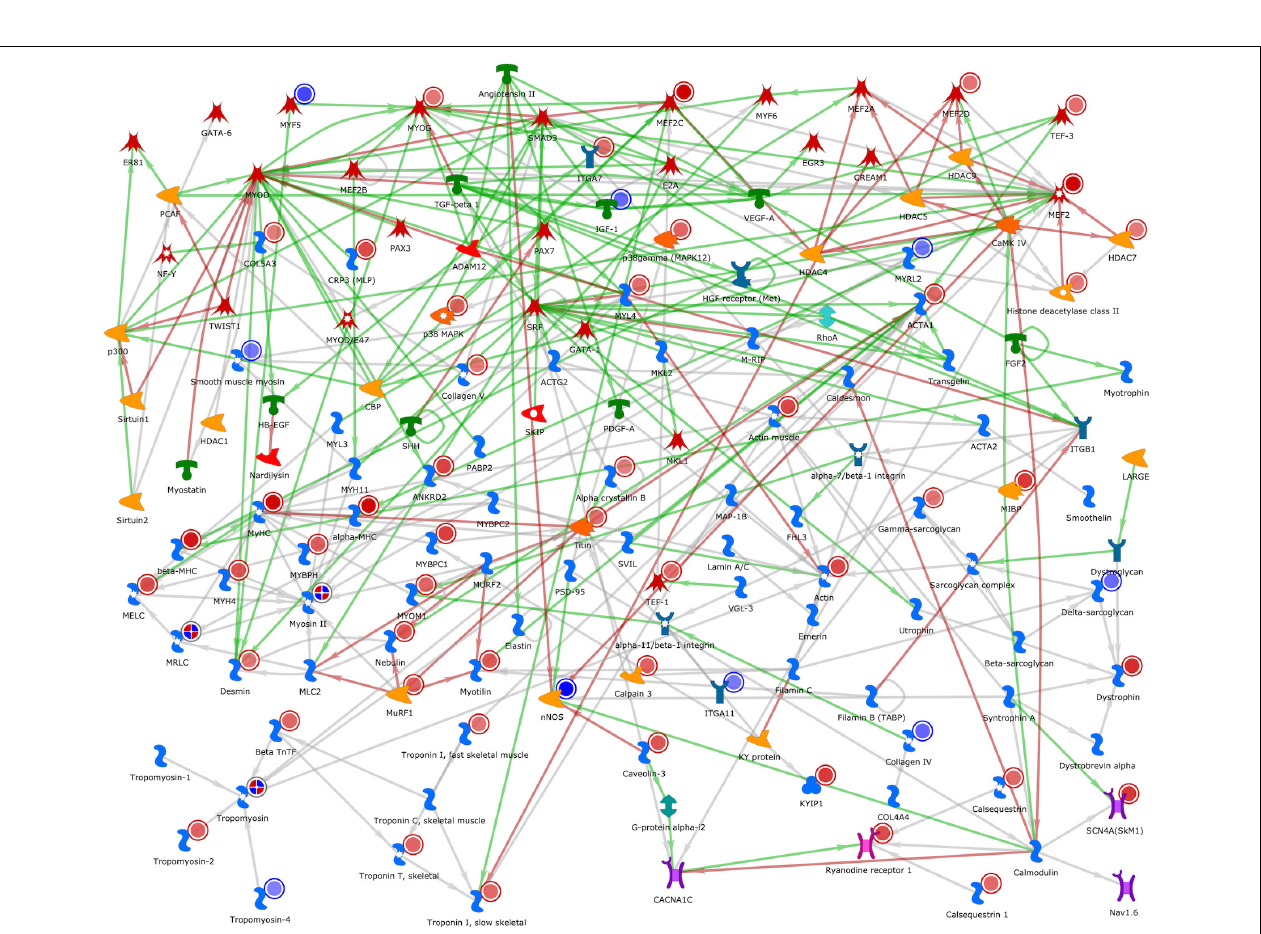
FIGURE 5 | Developmental skeletal muscle network representing genes related with this process based on the DE genes analysis. The genes with red circles are genes that were upregulated after the DE analysis. Genes marked with blue circle were downregulated in our DE gene analysis. The red lines between the objects mean positive/activation effects; the green lines, negative/inhibition effects; and the gray lines, unspecified effects. Image created by MetaCore software.